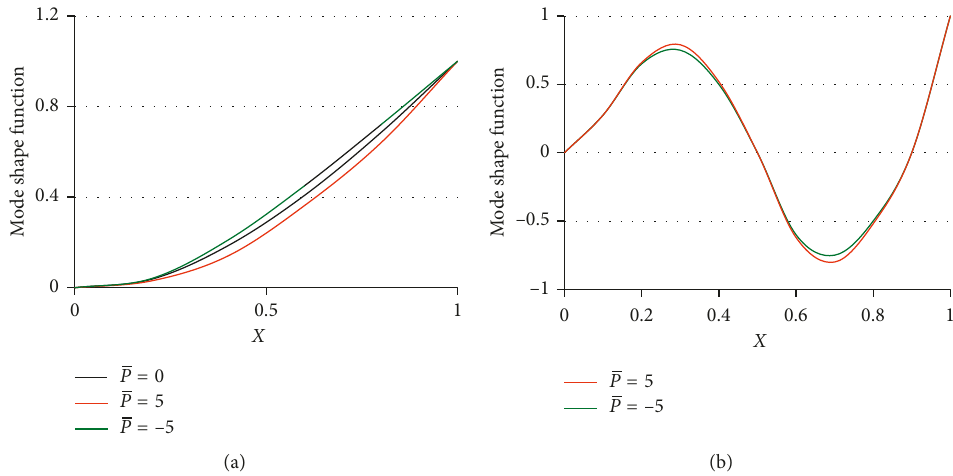
Figure 5: Effect of axial load on mode shapes with K